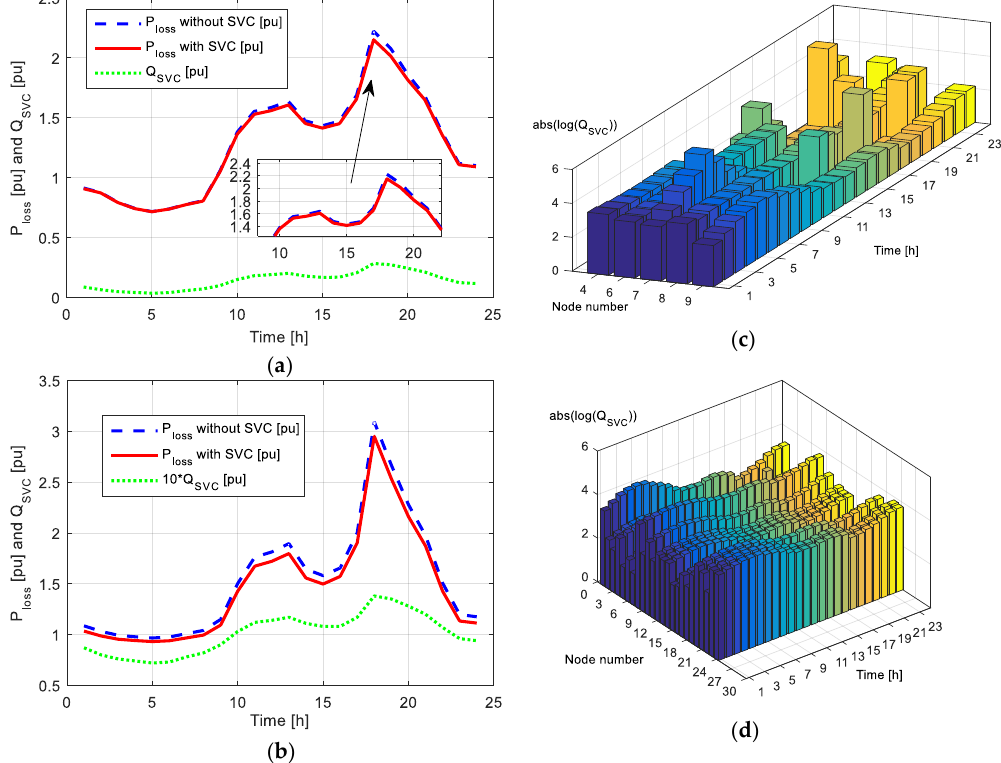
Figure 11. Power losses and reactive power of SVC device connected in the optimal node for ( a ) IEEE 9 and ( b ) IEEE 30 test bus system, as well as 3D graphs (node number-time-reactive power) for ( c ) IEEE 9 and ( d ) IEEE 30 test bus systems with a wind generator.